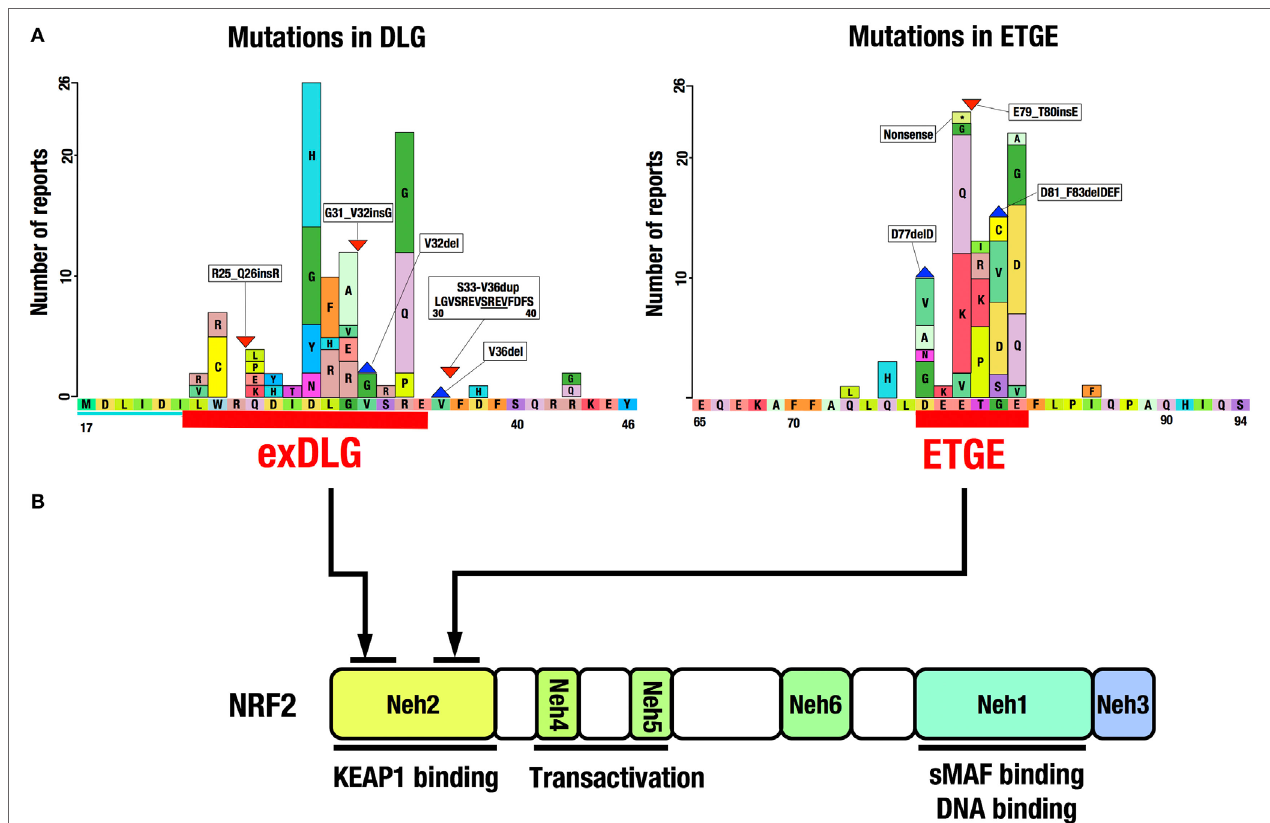
FigURe 4 | Distribution of somatic mutations in the NRF2 gene in cancers . (A) NRF2 mutations in the exDLG and ETGE motifs. Red lines indicate the DLG motif and the ETGE motif. Please see Ref. (10). (B) The domain structure of the NRF2 protein. NRF2 mutations are exclusively found in the DLG and ETGE motifs responsible for binding to